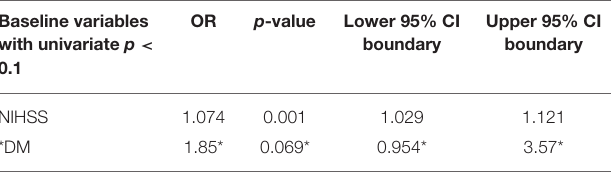
TABLE 4 | Results from multivariate regression analyses using NIHSS score upon admission and incidence of DM to predict the incidence of HT. Baseline variables with univariate p <